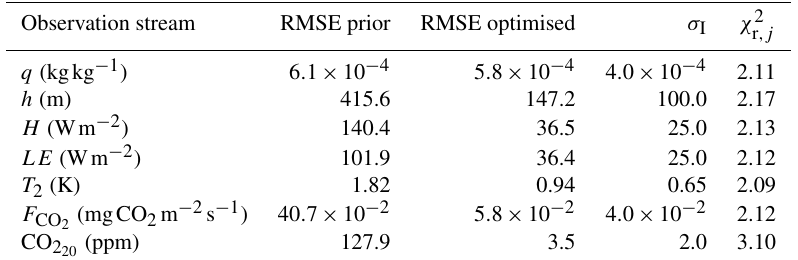
Table 5. The prior and posterior root mean squared error (RMSE), the specified measurement error standard deviation ( σ I ), and the partial reduced chi-square statistic ( χ 2 ) for the observation streams in the bias correction OSSE with perturbed observations. The RMSE and χ 2 r ,j values are for the member with the lowest posterior cost function, i.e. the member with unperturbed prior. Note that the measurement error equals the observational error here, since the model and representation errors were set to 0 for simplicity. All weights for the cost function were set to 1. We used a total of 280 individual (artificial) observations in the cost function. See Table A2 for a description of the observation